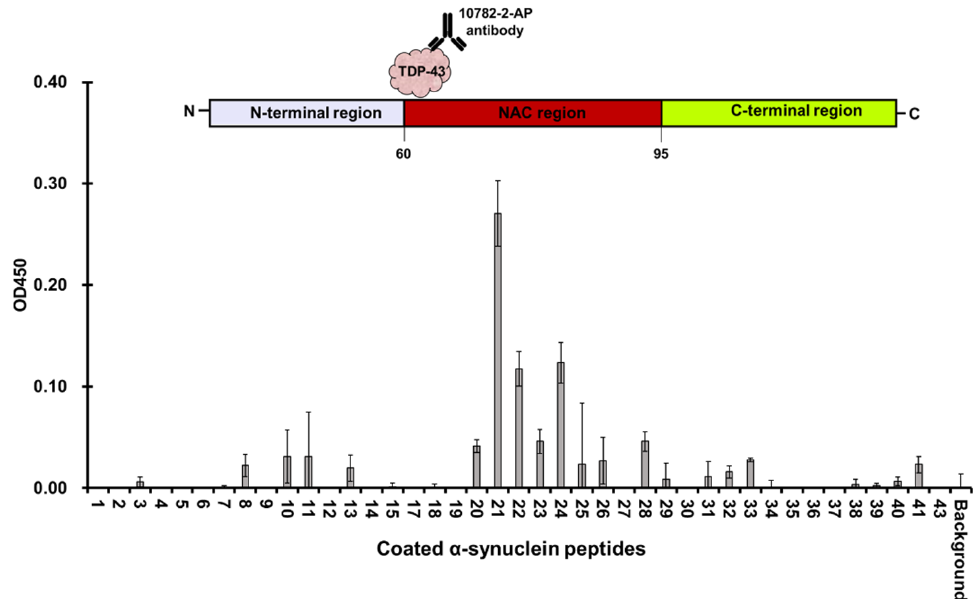
Figure 9. Full length TDP-43 bound most significantly to the first 16 residues of the NAC domain of α -synuclein.